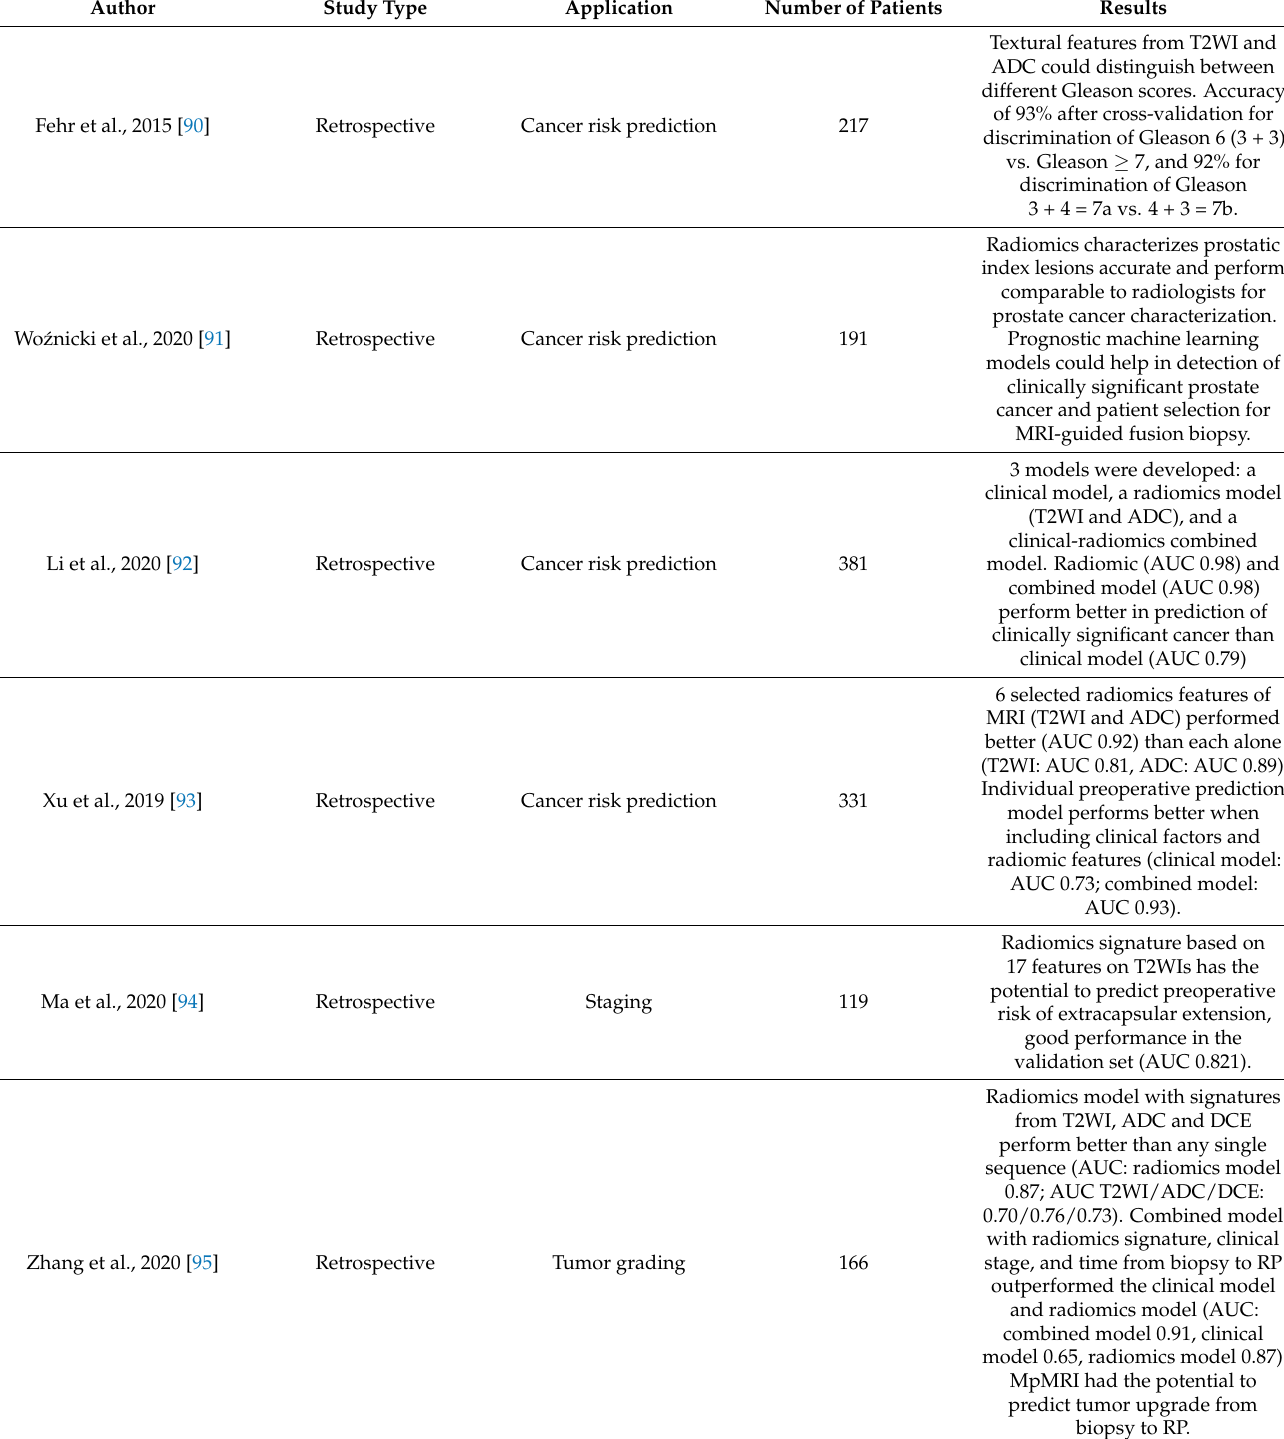
Table 2. Summary of radiomics literature in prostate cancer using